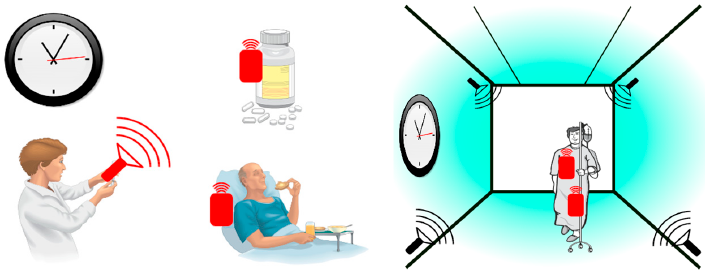
Figure 1. Two application scenarios for Yoking proofs (drugs administration and ubiquitous patients’ physiological functions monitoring in clinics or ambient assisted living).